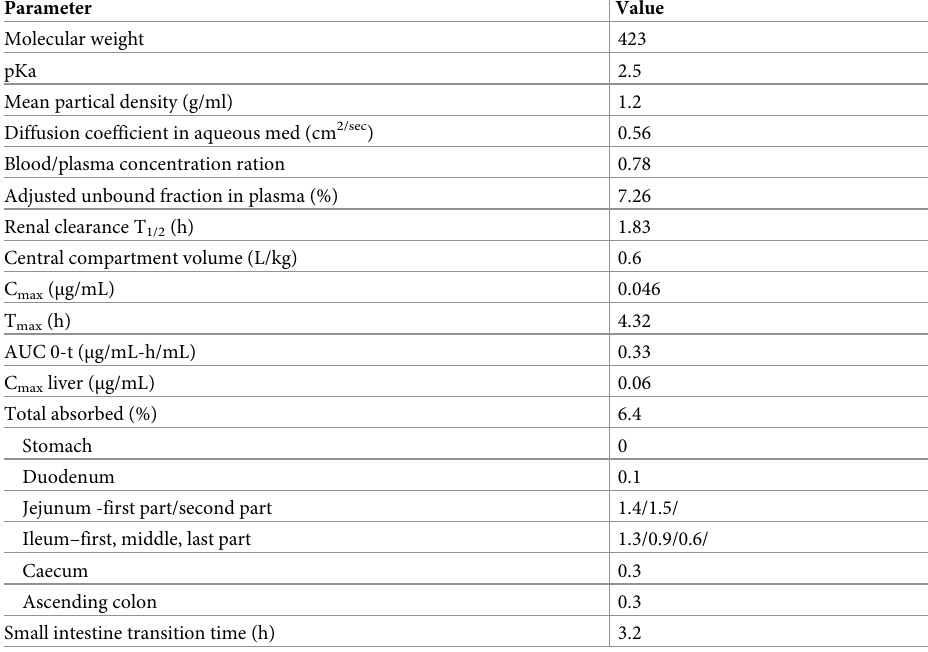
Table 1. In silico predictions of physiochemical and pharmacokinetic properties of JBC 1847. Parameter Value Molecular weight